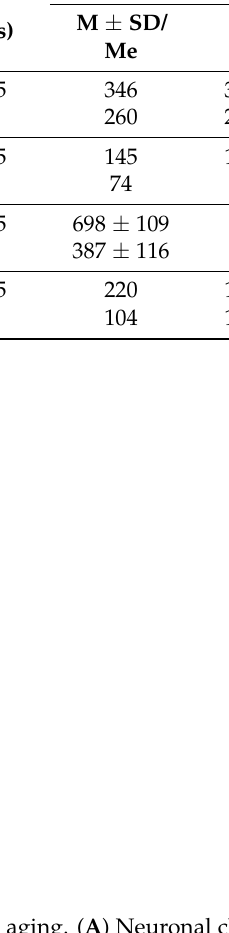
Figure 1. Morphologic changes in neurons during aging. ( A ) Neuronal chromatolysis and “ghost form” of neurons; ( B ) Lewy bodies (arrow) with a dense and intensely colored core and a clear amorphous peripheral part in the nigrostriatal neuron; ( C ) Two eosinophilic intranuclear inclusions near the nucleoli (Marinesco bodies (arrow)) in the nigrostriatal neuron; ( D ) Clusters of corpora amylacea (some of them demonstrating a lamellar structure) in the precentral gyrus near sub- arachnoid space; ( E ) Senile plague (arrow) in the precentral gyrus cortex. ( A )—Nissl stain, × 400; ( B – E )—Hematoxylin and eosin stain, ×